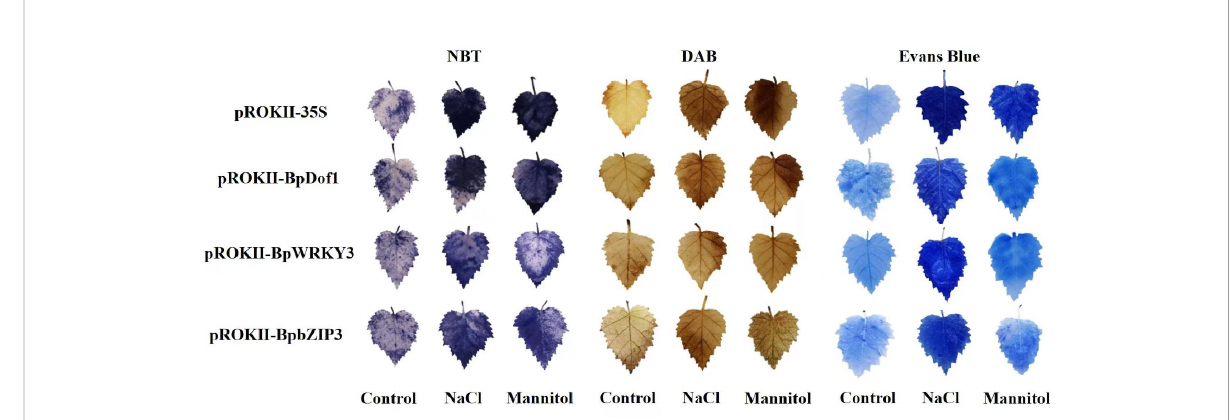
FIGURE 11 Analysis of ROS accumulation and cell membrane damage in overexpressing BpDof1 , BpWRKY3 , and BpbZIP3 plants under salt and osmotic stress. Birch plants overexpressing BpDof1 , BpWRKY3 , and BpdZIP3 were generated by transient transforming them with pROKII-35S:: BpDof1 , pROKII-35S:: BpWRKY3 , and pROKII-35S:: BpbZIP3 , respectively. The empty pROKII was transiently transformed into birch plants. After exposure to salt stress of 150 mM NaCl and mannitol stress of 200 mM for 12 h. Plants watered with fresh water were used as control. All birch plants